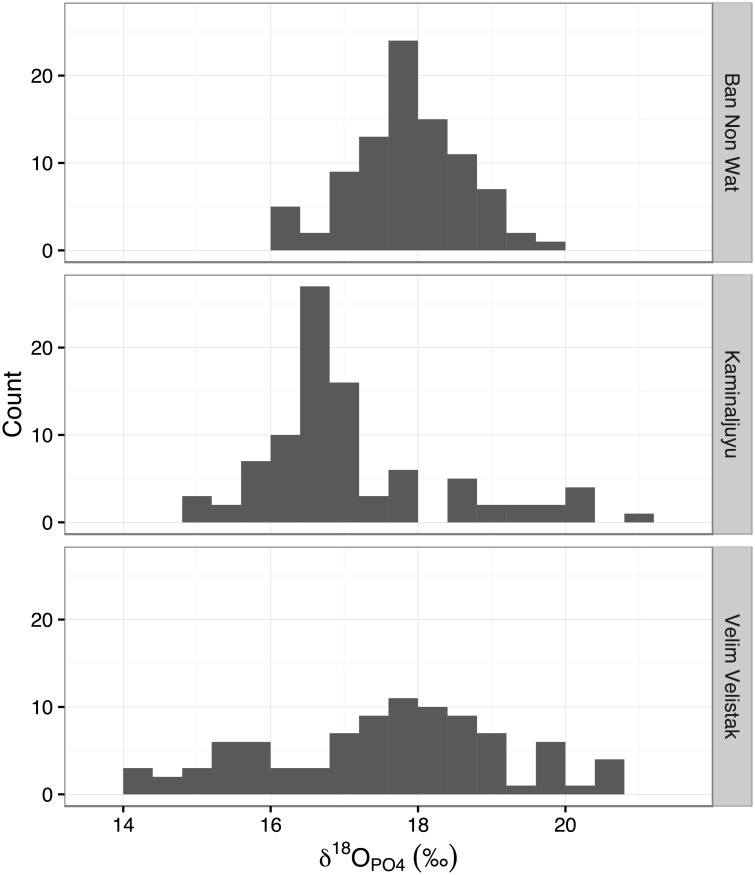
Histograms of data in the Post-Infant Dentition data-subset from the sites of Ban Non Wat, Kaminaljuyu and Velim-Velištak.Data from: Ban Non Wat—King et al. 2013; Kaminaljuyu—White et al. 2000, Wright et al. 1998, Wright et al. 2010; Velim Velištak—Lightfoot et al. 2014. Note that specimens from Kaminaljuyu have been analysed in multiple studies.